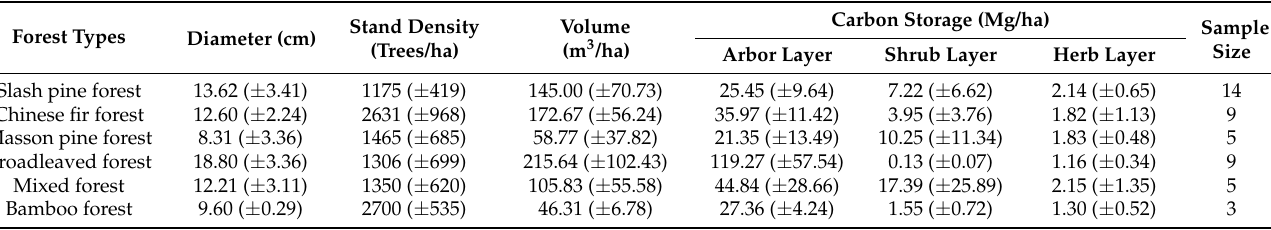
Table 1. Stand characteristics of the six